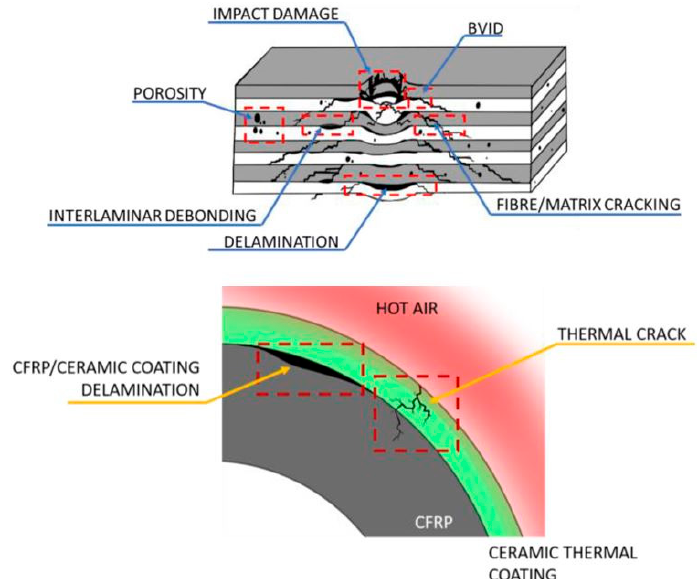
Figure 1. Composite structure defects leading to the need for advanced structural health monitoring methods [7].